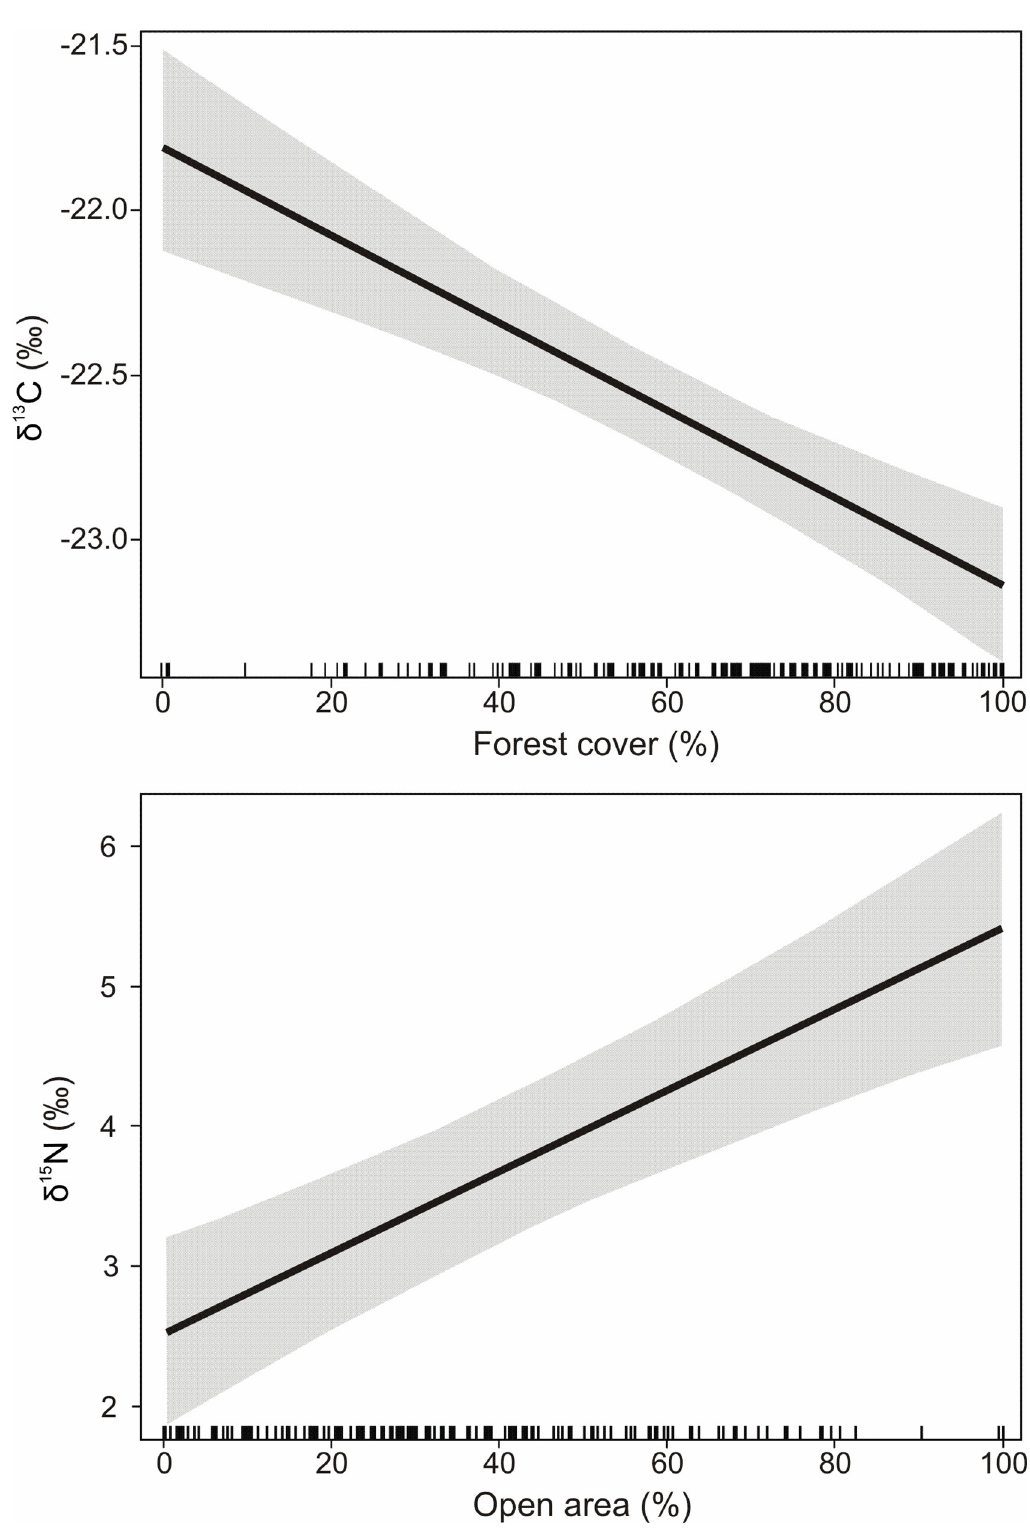
Fig 3. Influence of forest cover (top) and open area (bottom) in buffers around red deer localities on carbon and nitrogen stable isotope compositions ( δ 13 C and δ 15 N values) in bone collagen of the studied individuals based on estimates from multiple regression models. Grey areas– 95% confidence intervals of the regression